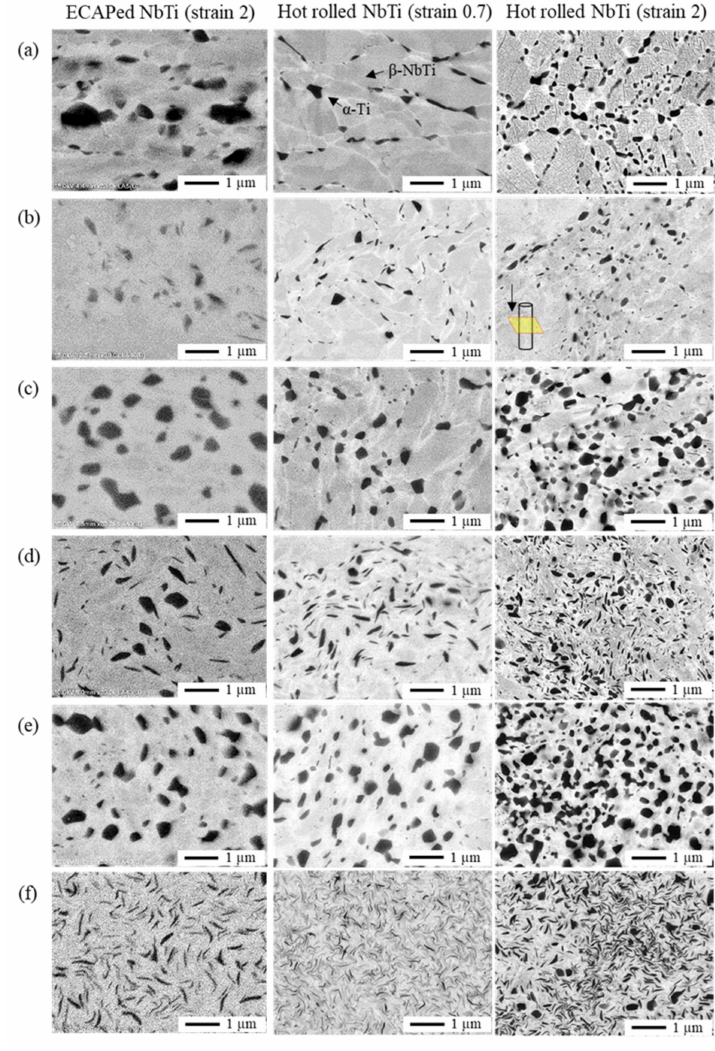
Figure 4. BSE (back scatter electronic) images depicting the microstructures after ( a ) 1st heat treatment, ( b ) groove rolling, ( c ) 2nd heat treatment, ( d ) 1st drawing, ( e ) 3rd heat treatment and ( f ) 2nd drawing. All images are taken from an axial direction. BSE images of ECAPed specimen with strain 2.0, and hot rolled specimen with strain 0.7, are reused from references [16,17],